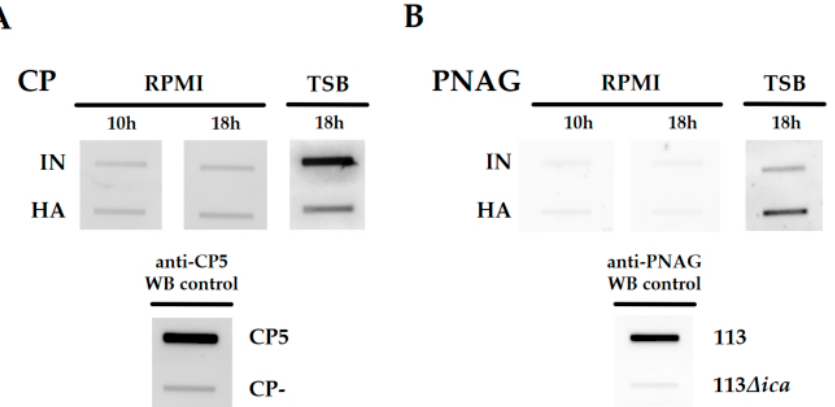
Figure 3. Immune-based detection of CP and PNAG. Slot blot analysis of CP and PNAG after 10 h growth in RPMI and 18 h growth in RPMI and TSB, including control strains. ( A ) CP extracts of IN, HA and the control strains Reynolds CP5 and CP- were used 1:100 diluted for the analysis. ( B ) All PNAG extracts (IN, HA, 113, 113 Δ ica ) were used 1:10 diluted for the antibody-based detection ( A , B ). Data are representatives of three independent experiments. IN, initial isolate; HA, host-adapted